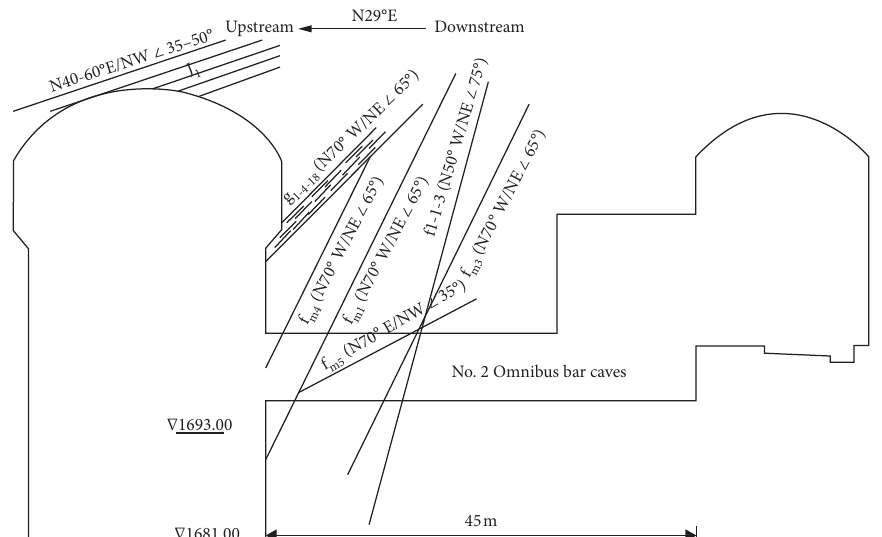
Figure 4: A typical geological cross-section of Houziyan hydropower station powerhouse along the center line of 2# omnibus bar cave (stake 0+51.3m) (modified after Dong et al. [36]).